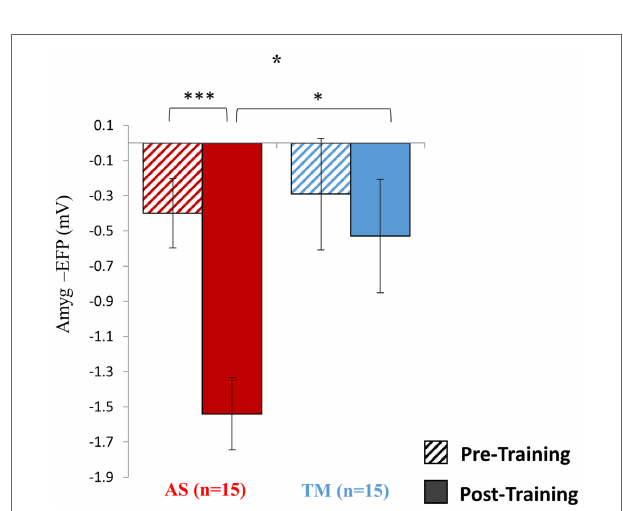
FigUre 3 | Pre vs. post training results . Training with the AS interface resulted in an overall stronger effect on the targeted brain activity. The figure demonstrates that only the AS group showed a reduction in the mean amyg-EFP signal amplitude ( y -axis) during the last (solid fill) compared to the first (dashed fill) NF trial. Furthermore, while pre-training no differences were observed between the groups, during the last NF trial the AS group showed lower amyg-EFP signal amplitude. * p < 0.05, *** p < 0.001.